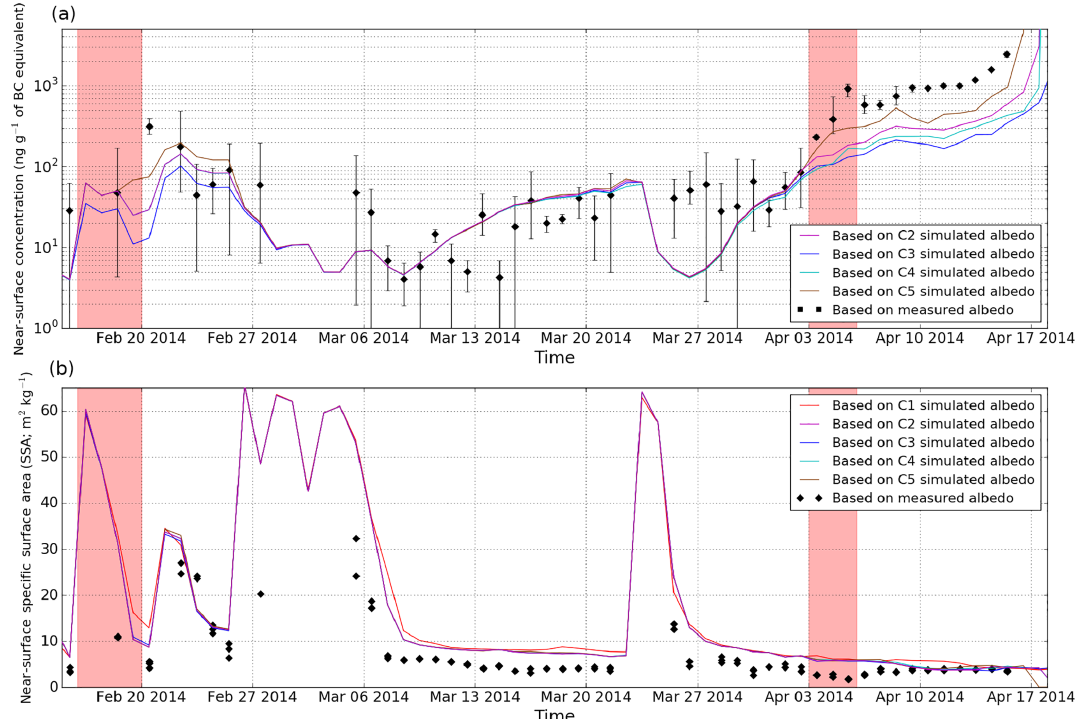
Figure 4. Surface BC equivalent concentration (a) and SSA (b) computed from measured and simulated albedo. For simulated albedo, the different Crocus configurations are detailed in Table 1. These data have been computed using the Dumont et al. (2017) algorithm, and the two major Saharan dust events are represented by the red areas.